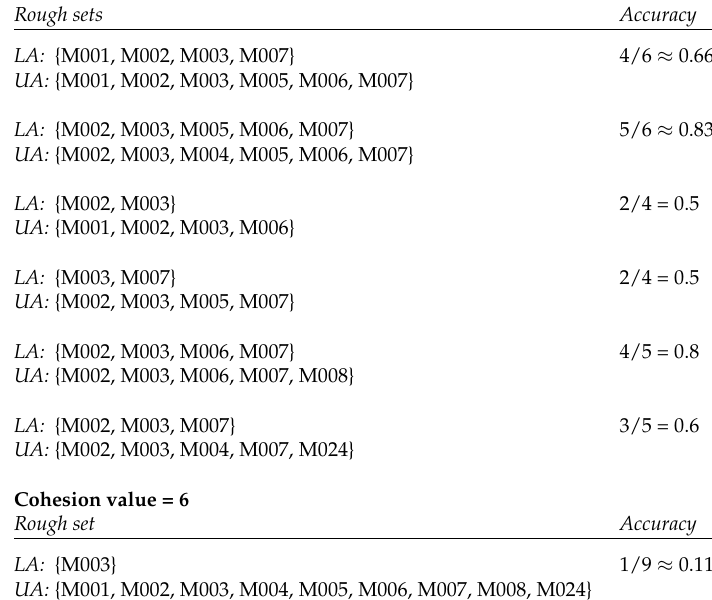
Figure 2. Rough sets resulting from clustering the activity spaces of sleeping with cohesion values 2 and 6. The spatial markers in the Aruba data set that correspond to motion sensors are denoted by ‘M’ and a three-digit number. LA denotes the lower approximation and UA the upper approximation of the rough set.